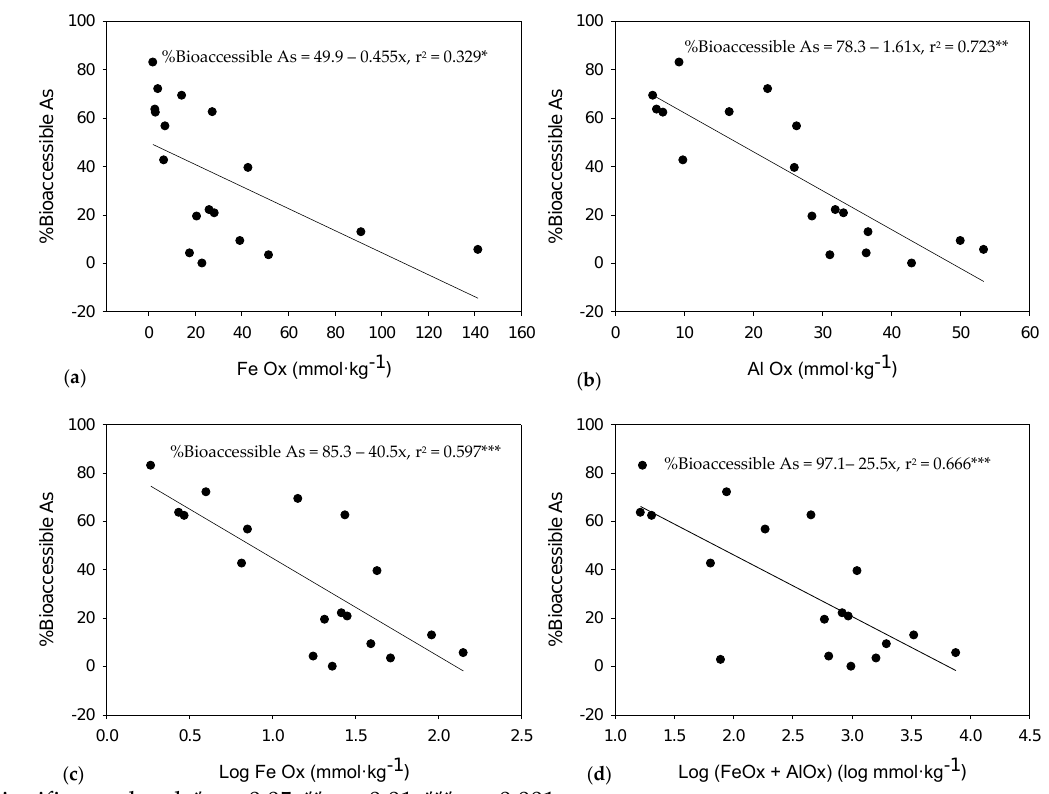
Figure 1. Effect of hydrous oxides on %bio-accessible (IVBA) As. ( a ) FeOx (mmol · kg − 1 ) effect on %bio-accessible As ( b ) Al Ox (mmol · kg − 1 ) effect on %bio-accessible As ( c ) Log FeOx (mmol · kg − 1 ) effect on %bio-accessible As ( d ) Log (FeOx + AlOx (log mmol · kg − 1 ) effect on %bio-accessible.